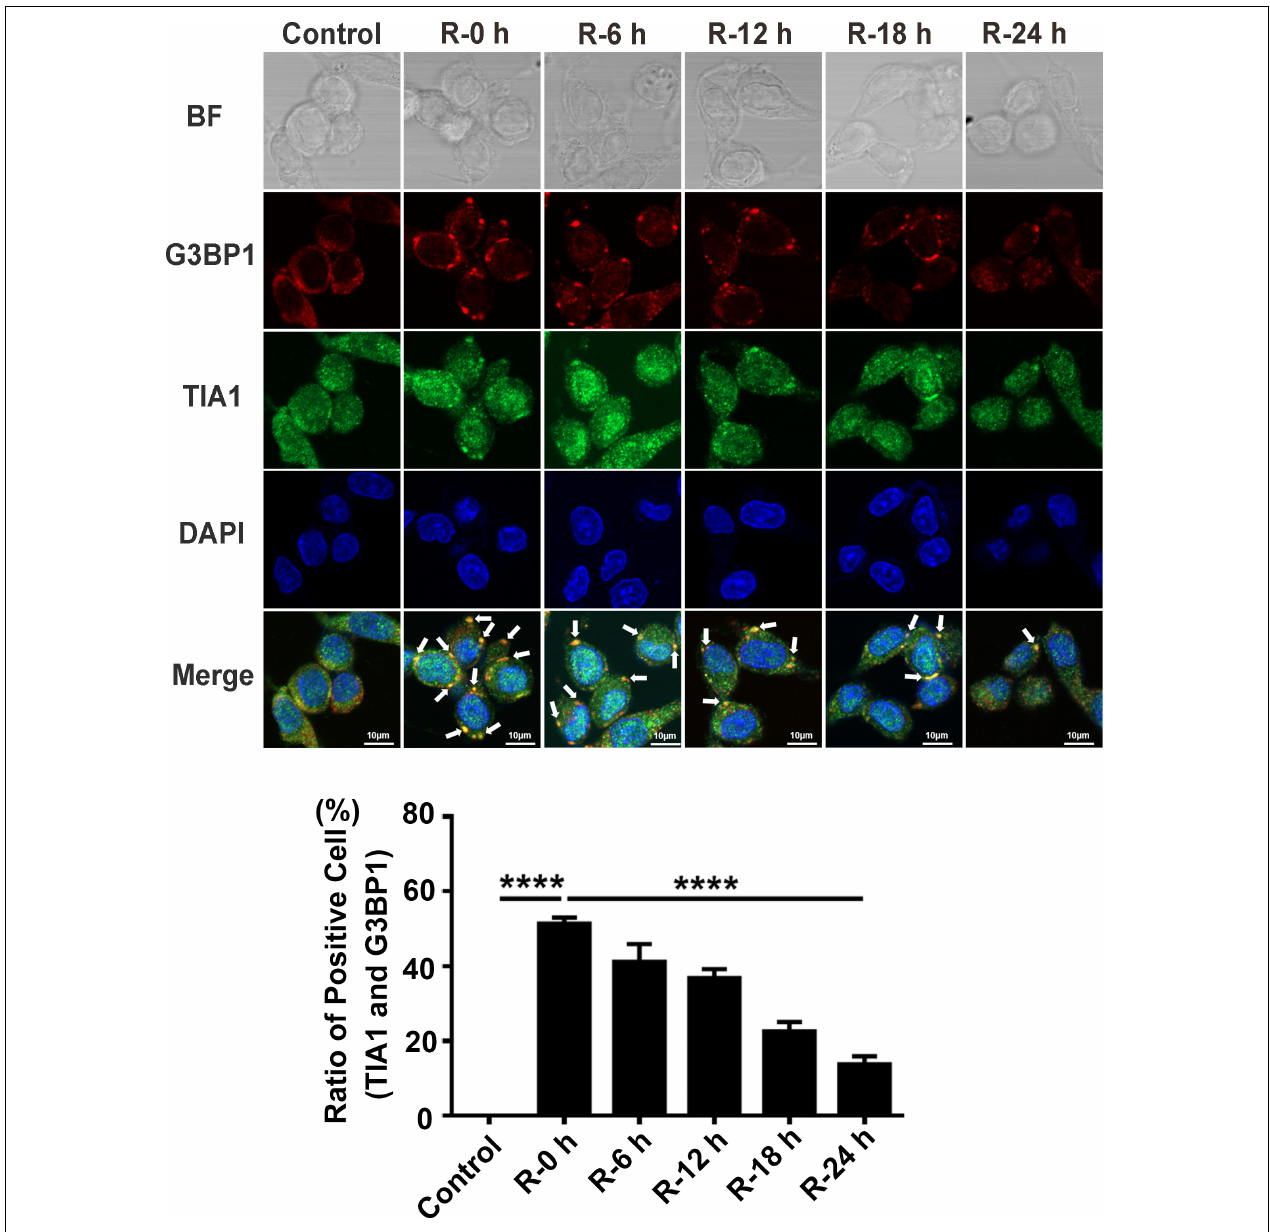
FIGURE 2 | The dynamic generation of SGs at different time points of reperfusion under OGD/R condition in PC12 cells. SG formation in PC12 cells at 0, 6, 12, 18, and 24 h of reperfusion after 6 h of OGD stimulation was detected with double-labeled immunofluorescence (TIA1 and G3BP1). **** , compared with R-0 h group; P < 0.0001. SGs were labeled with TIA1 (green) and G3BP1 (red), and the nucleus was labeled with DAPI (blue). Scale bars: 10 µ m.